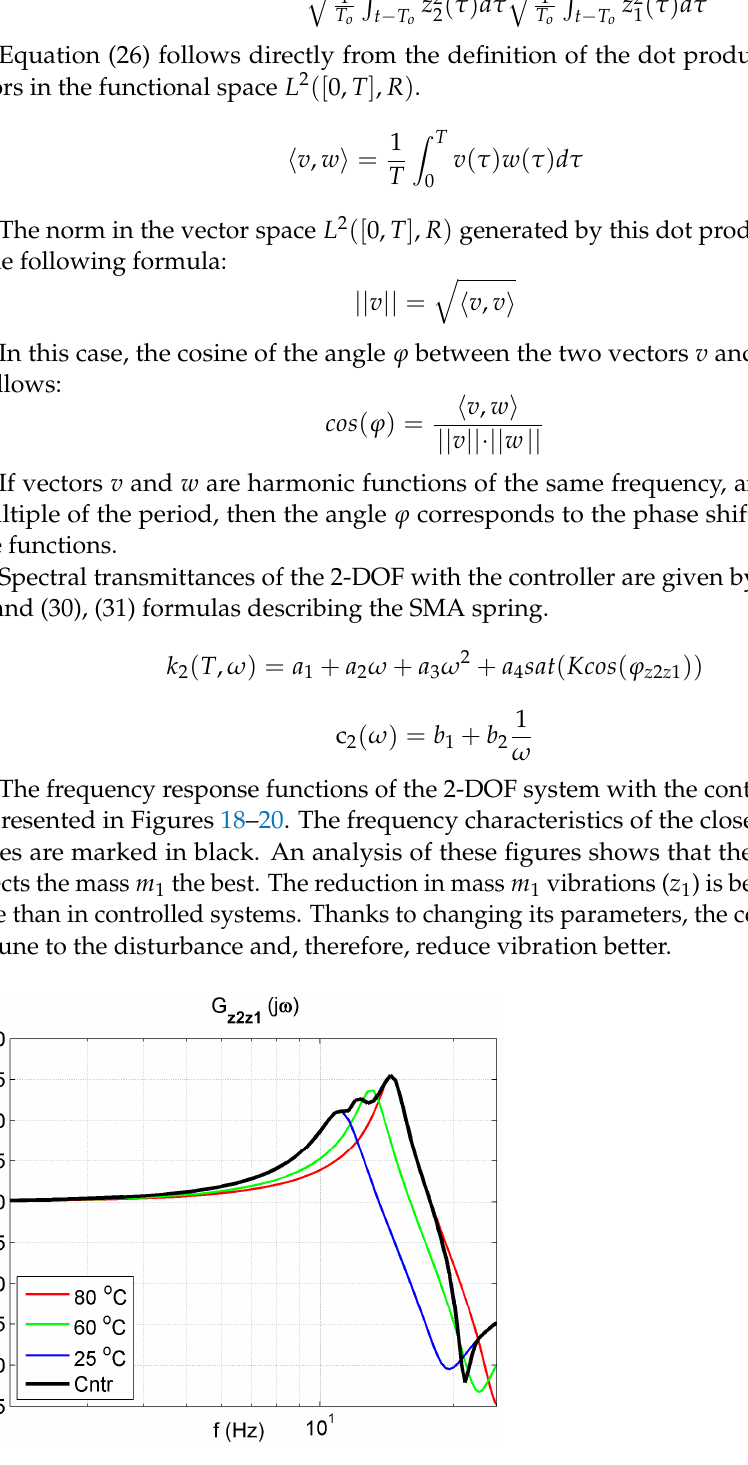
Figure 18. Vibration transmissibility functions of the passive absorber for selected temperatures of 25 ◦ C, 60 ◦ C, 80 ◦ C and the controlled absorber (black). The transfer function G z 2 z 1 describes the